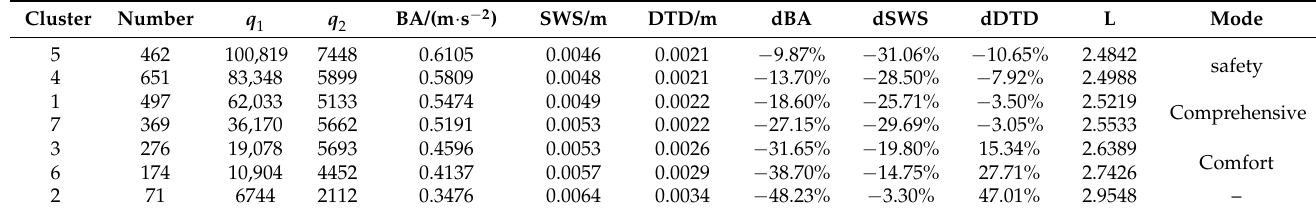
Table 5. Averages of clustering results of B-20 subset.